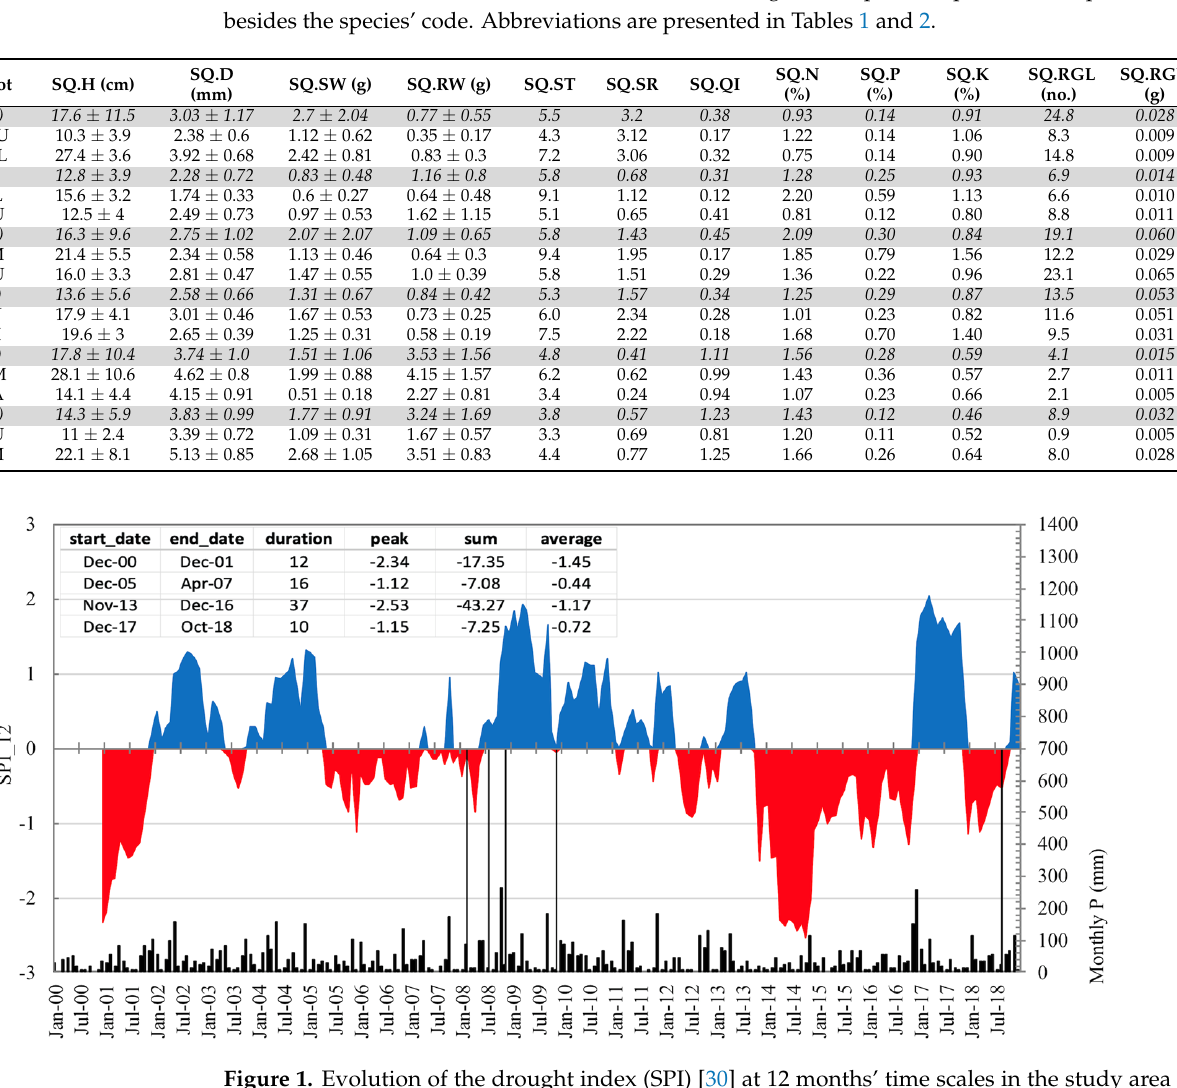
Figure 1. Evolution of the drought index (SPI) [30] at 12 months’ time scales in the study area for the period 2000 to 2018. Red and blue areas correspond to drought and wet spells, respectively. The five thin black vertical lines refer to dates of field assessment in this study, where the first three lines encompass the two early growth periods considered (first spring and first summer). Black vertical bars refer to monthly precipitation. The inset table represents the values of duration, intensity, and magnitude of the four most important drought spells in the series in units of SPI-12.